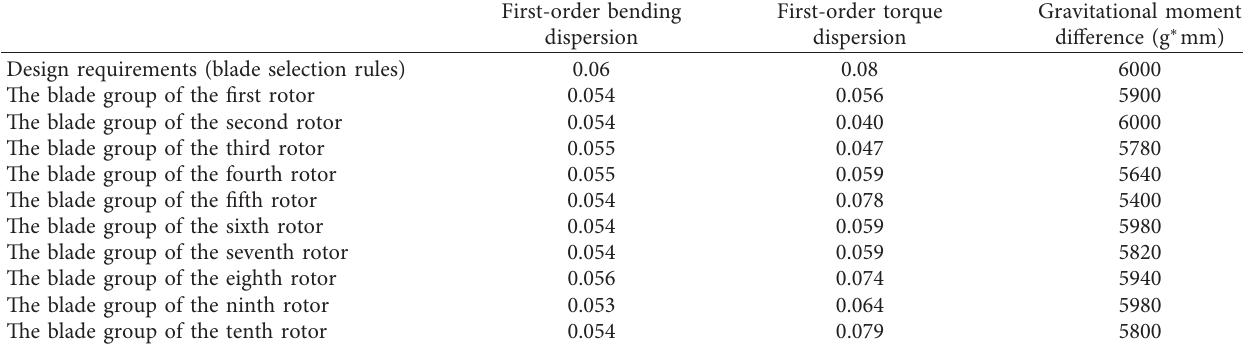
Table 4: Ten groups of rotating blades picked out by the algorithm based on the collocation degree of